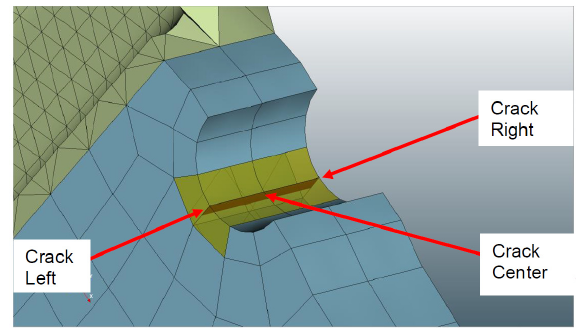
Figure 13. Straight crack positions.